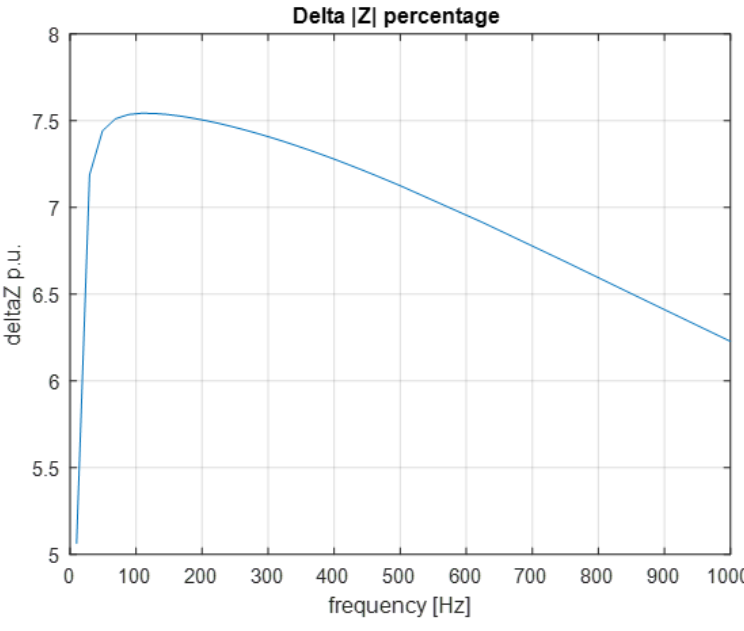
Figure 27. impedance